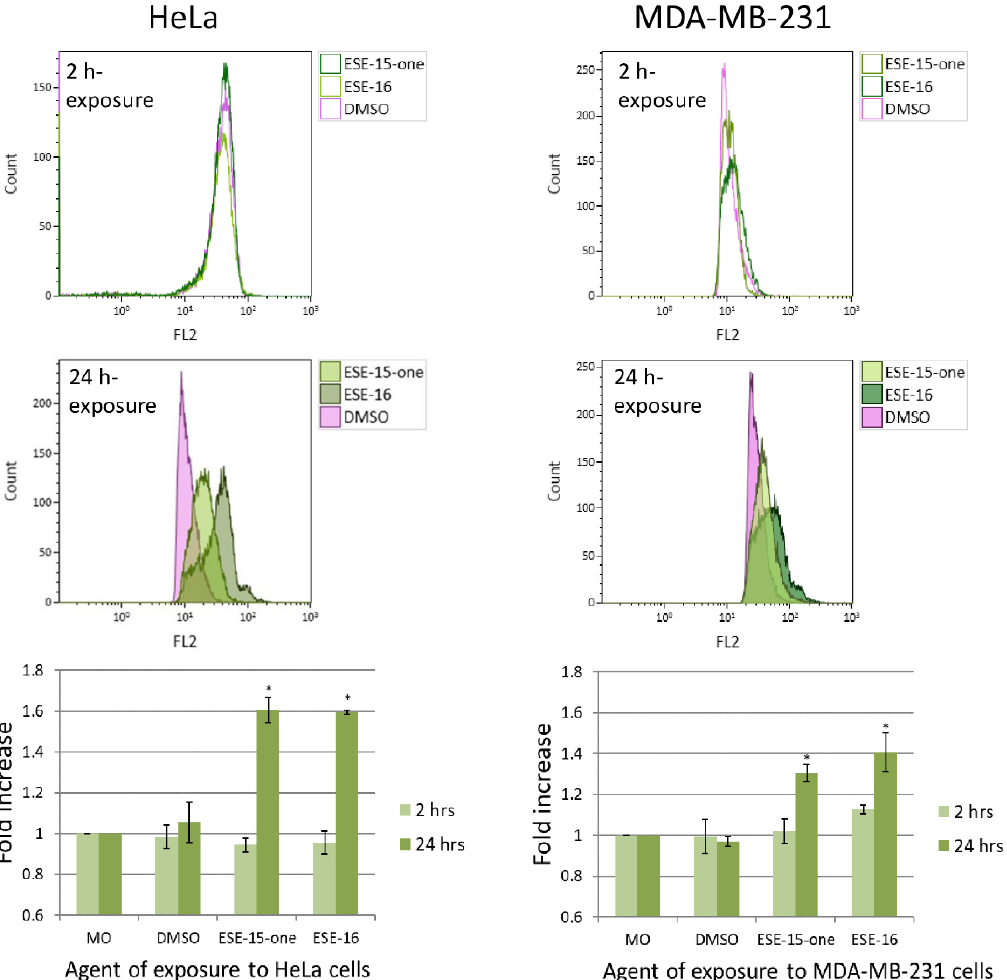
Figure 6. Overlay histograms and bar charts representing the fold-increase in superoxide production in HeLa and MDA-MB-231 cells after a 2- and 24-h ESE-15-one and ESE-16 exposure. Bar charts represent the mean fold-increase over 3 biological repeats, error bars indicate SEM, and * p < 0.05.